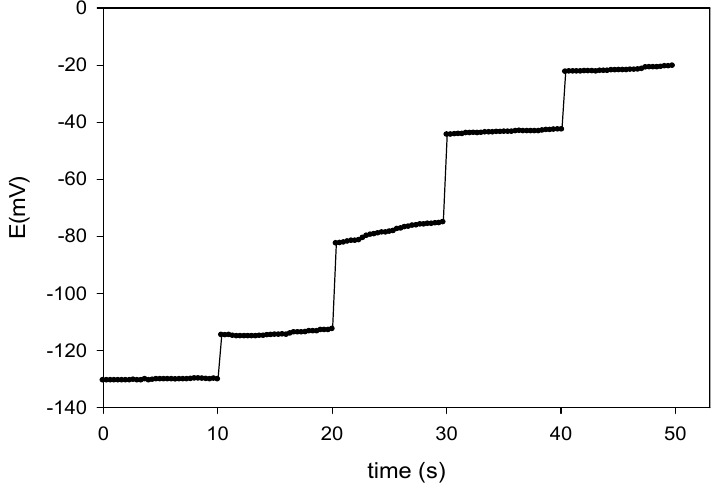
Figure 4. Dynamic response of N-hydroxysuccinimide–NPOE membrane electrode, with one decade step changes of concentration (10 − 6 to 10 − 2